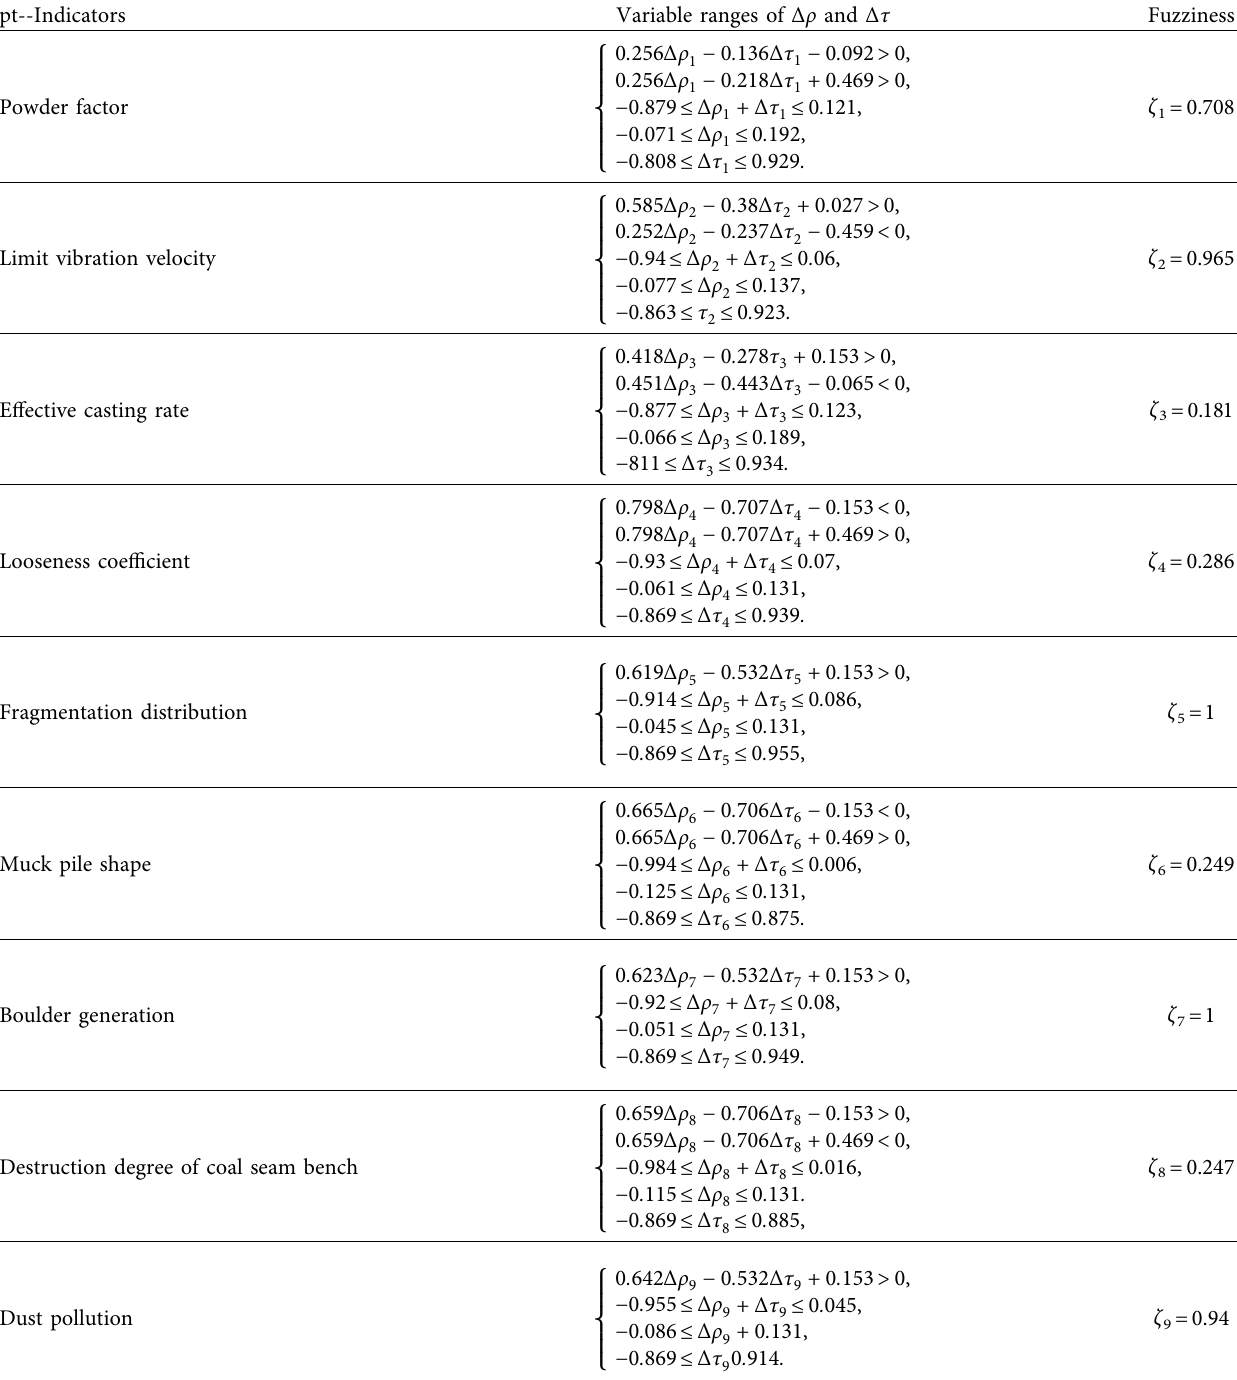
Table 5: Fuzzy analysis of indicator